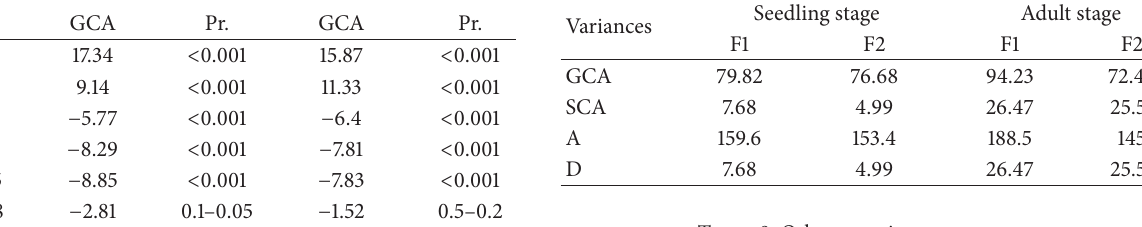
Table 9: Other genetic components.